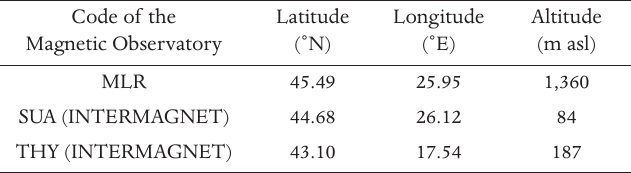
Table 1. The locations of the magnetic observatories used in the correlation